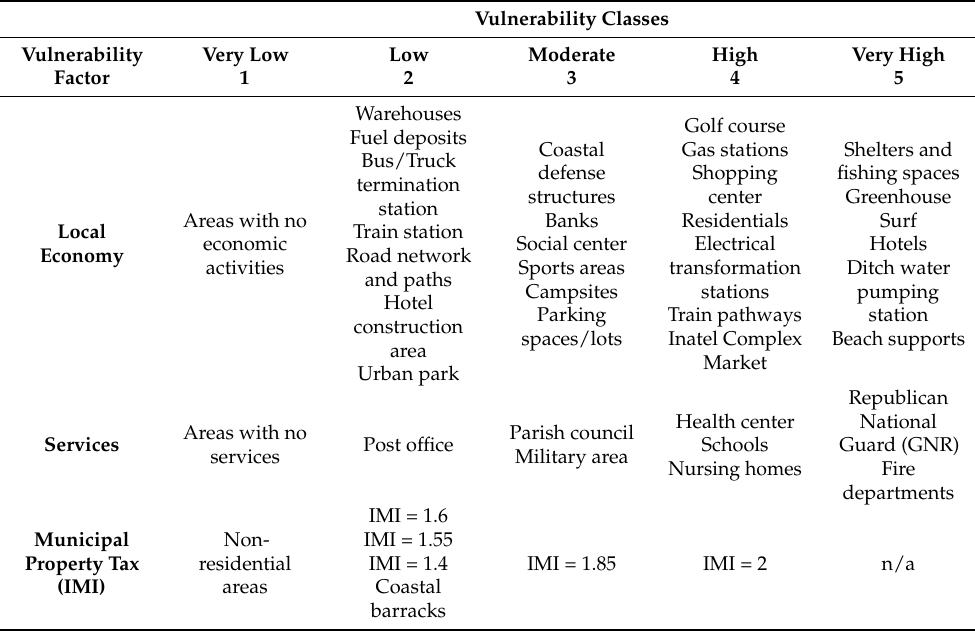
Table 11. Vulnerability classification concerning the contribution to the local economy, services, and Municipal Property Tax (IMI) vulnerability